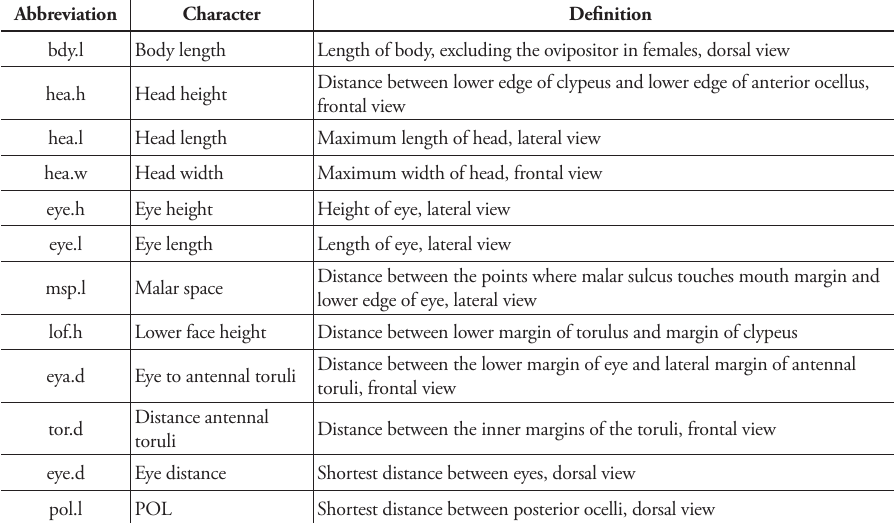
Table 1. List of characters used in this study, with character definition and abbreviation as also used